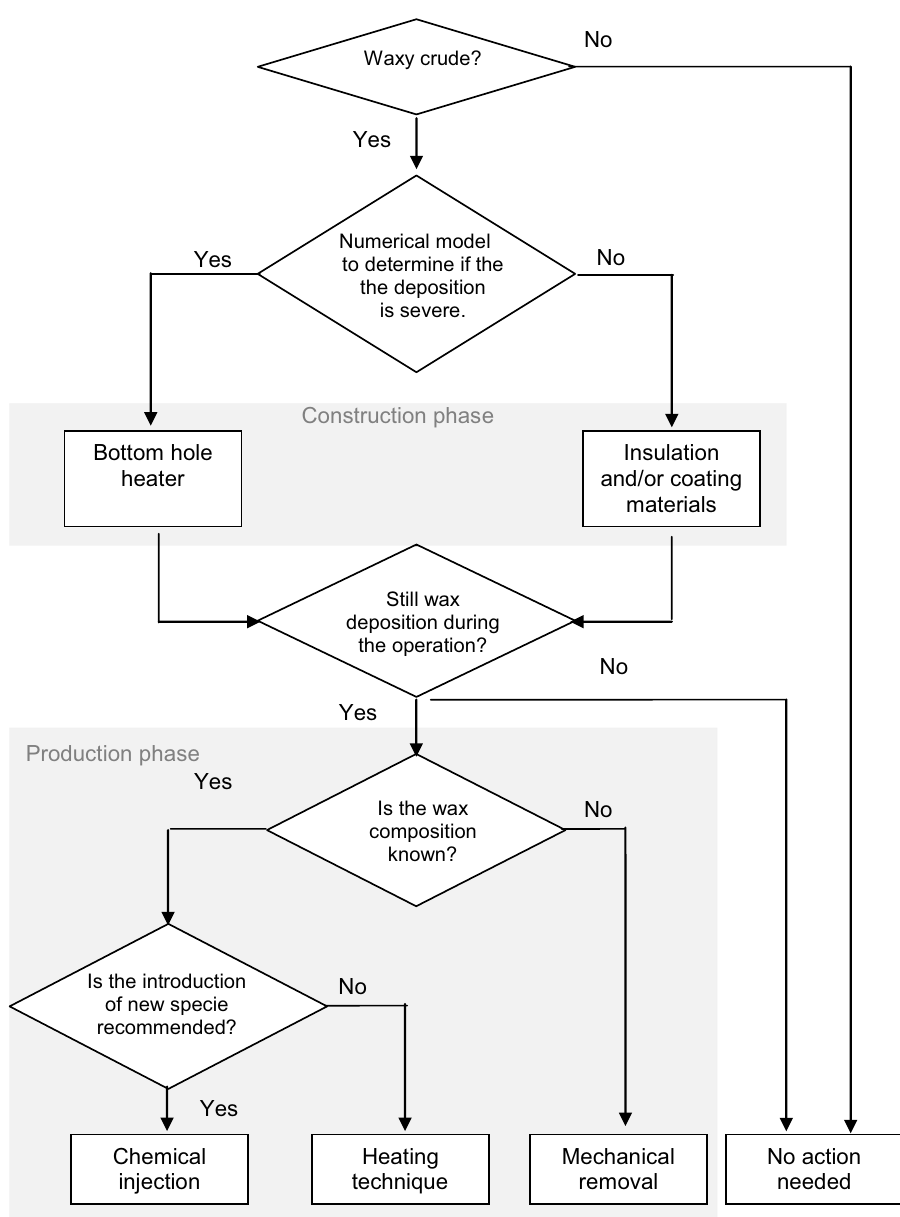
Fig. 8 Decision tree to choose the wax deposition preventing or removal